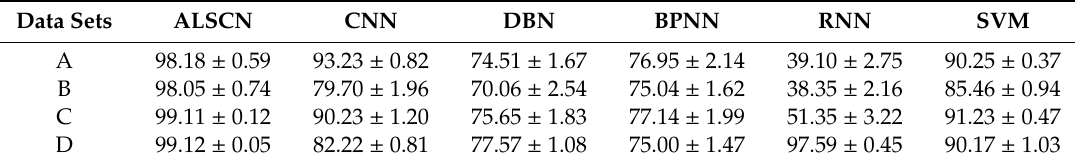
Figure 15. Comparison of test accuracy of different networks. Table 8. The accuracy of different models with different data sets on CWRU.